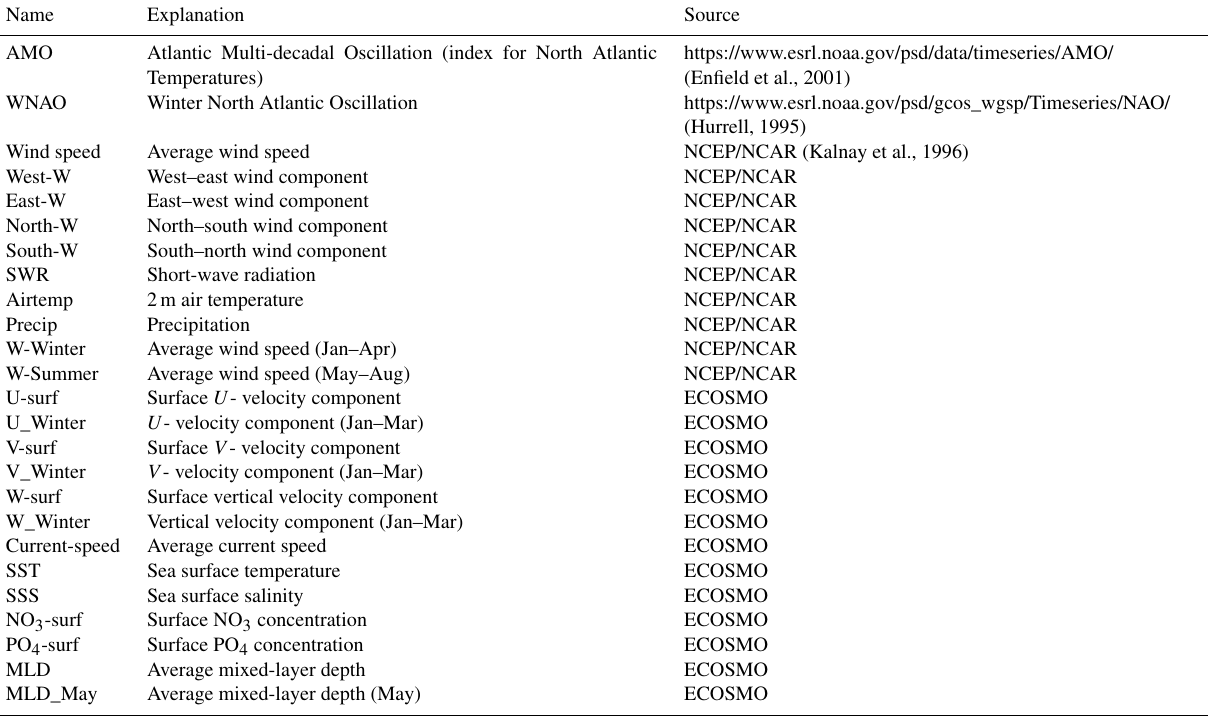
Table 1. Variables used for correlation analysis with principal components of the net primary production EOF analysis (Figs. 7 and 8). Both atmospheric and oceanic variables were averaged over the respective subregion (North Sea or Baltic Sea) for the analysis.